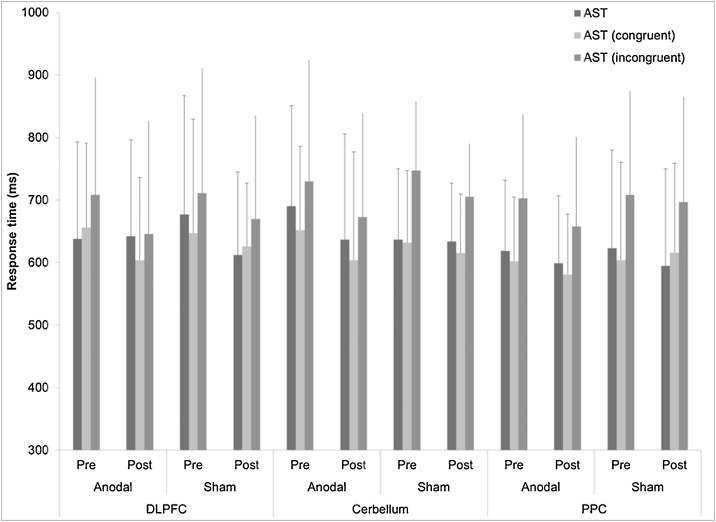
Comparison of attention switching task for mean correct latency, congruent and incongruent condition before and after anodal and sham stimulation for right dorsolateral prefrontal cortex, posterior partial cortex and cerebellum. Error bars are standard deviation.